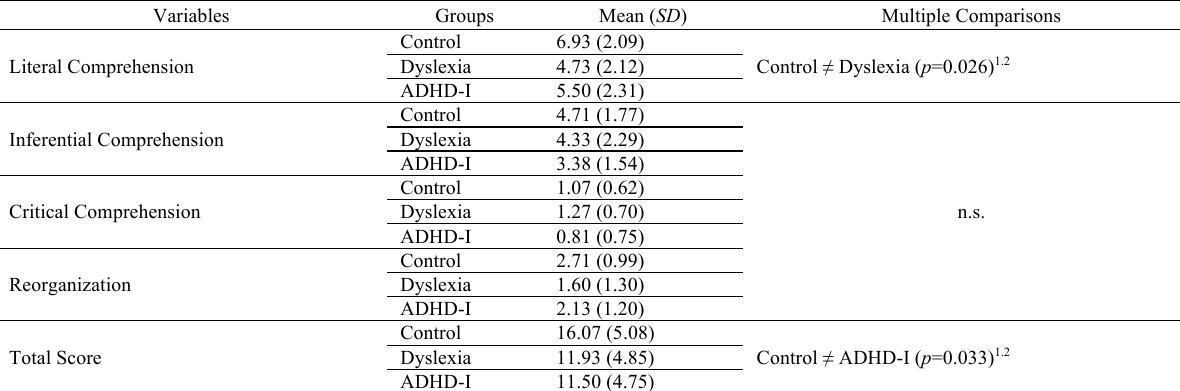
Table 15 – Means, standard deviations and ANOVA independent samples test: TCL – Reading Comprehension